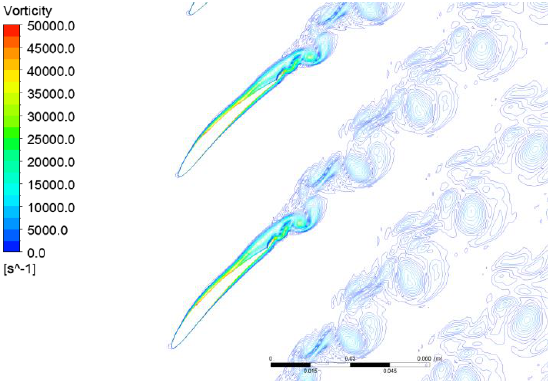
Figure 16. Instantaneous vorticity contour with excitation at 7 times the RF.